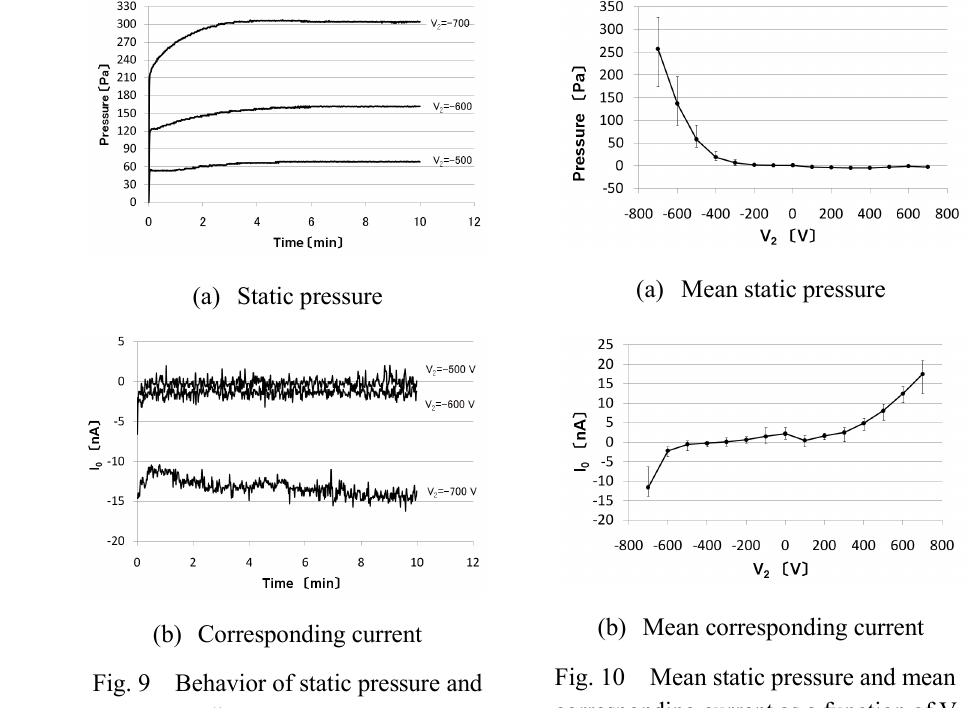
corresponding current as a function of V at V = 480 1